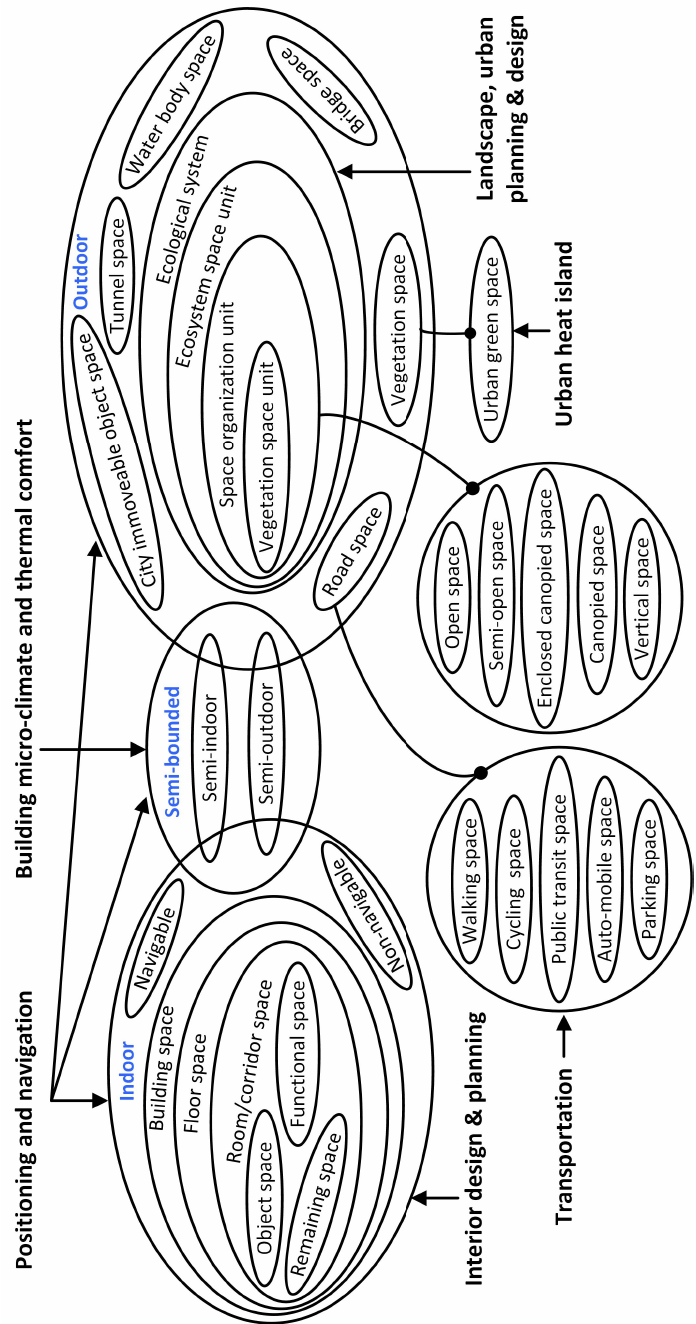
Figure 11. Overview of spaces from different